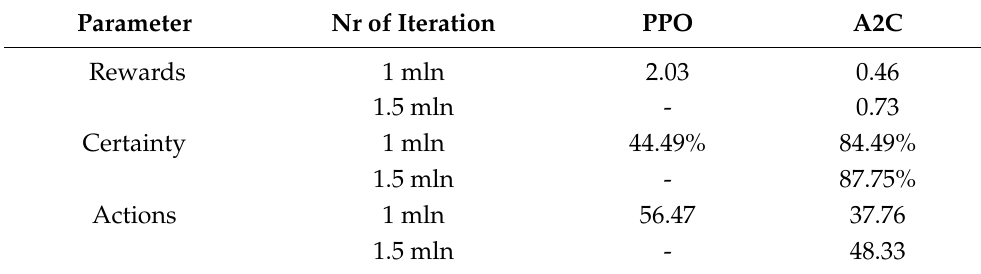
Table 3. Comparison of the performance—averages of 10,000. The table summarises the final performance after the particular number of learning episodes. It can be observed here how PPO performed better, even after a smaller number of learning